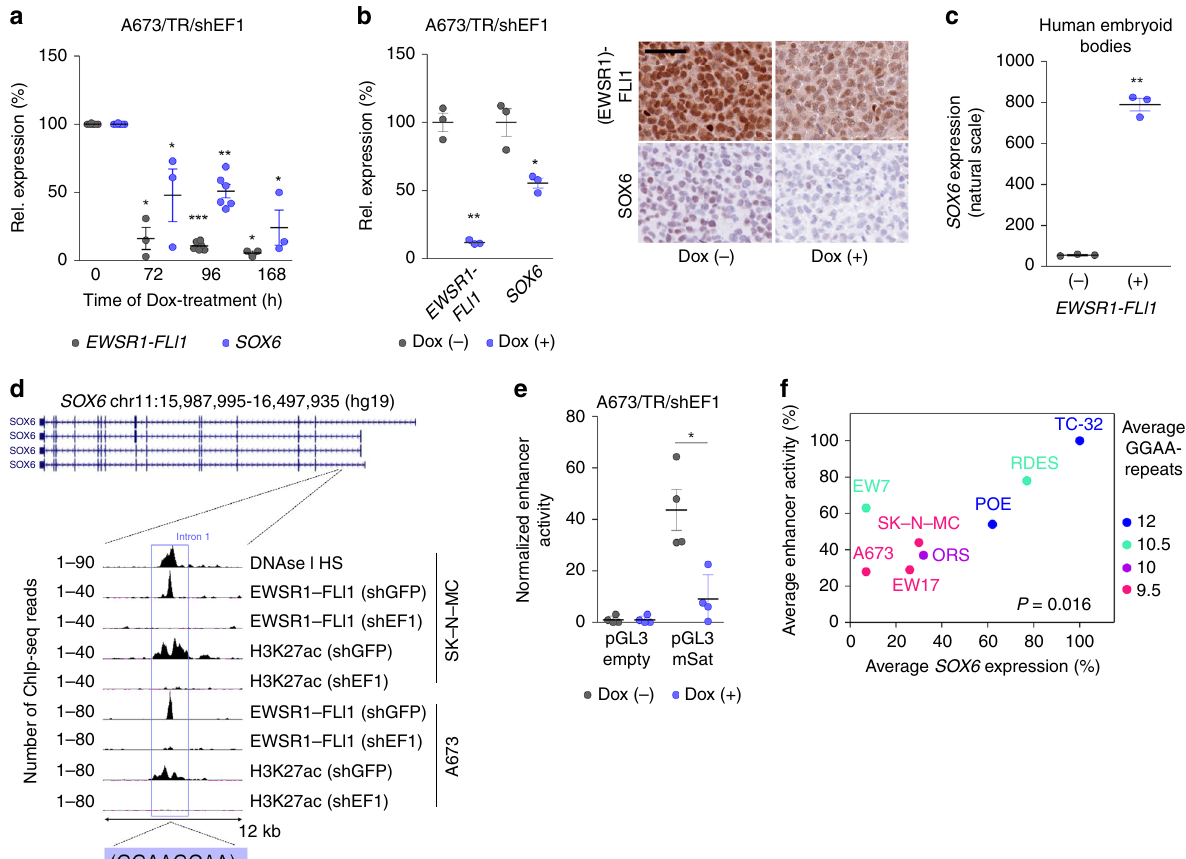
Fig. 2 EWSR1-FLI1 induces SOX6 expression via an intronic GGAA-mSat. a EWSR1-FLI1 and SOX6 expression (qRT-PCR) in A673/TR/shEF1 cells after addition of Dox. Horizontal bars represent means, n = 3 biologically independent experiments for time points 0 h, 72 h and 168 h, n = 6 biologically independent experiments for the time point 96 h. P values determined by two-sided Mann – Whitney test. EWSR1-FLI1: 72 h ( P = 0.012), 96 h ( P = 0.0007), 168 h ( P = 0.012); SOX6: 72 h ( P = 0.017), 96 h ( P = 0.001), 168 h ( P = 0.017). b Left: EWSR1-FLI1 and SOX6 expression (Affymetrix microarrays) in A673/ TR/shEF1 xenografts after 96 h of Dox-treatment. Horizontal bars represent means, n = 3 biologically independent xenografts per group. P value determined via two-sided independent one-sample t -test ( EWSR1-FLI1: P = 0.002, SOX6 P = 0.028). Right: Representative immunohistological staining for (EWSR1-)FLI1 and SOX6. Scale bar = 20 µ m. c SOX6 expression (Affymetrix microarrays) in embryoid bodies after ectopic EWSR1-FLI1 expression. Horizontal bars represent means, n = 3 biologically independent samples per group. P value determined via unpaired two-sided t -test with Welch ’ s correction ( P = 0.002). d Integrated genomic view of DNAse I hypersensitivity (HS) and ChIP-Seq data for EWSR1-FLI1 and H3K27ac in EwS cells transfected with shRNA against EWSR1-FLI1 (shEF1) or control shRNA (shGFP). e Relative enhancer activity of the SOX6 -associated GGAA-mSat in A673/ TR/shEF1 cells ( − / + Dox). Horizontal bars represent means, n = 4 biologically independent experiments. P value determined via two-sided Mann – Whitney test ( P = 0.029). f Correlation of the average enhancer activity of both alleles of the SOX6- associated GGAA-mSat and the average SOX6 levels across eight EwS cell lines (TC-32 set as reference). The color code indicates the average number of consecutive GGAA-repeats of both alleles. P value determined via two-tailed Pearson correlation test, n = 4 biologically independent experiments. All error bars represent SEM. *** P < 0.001, ** P < 0.01, * P < 0.05. Source data are provided as a Source Data fi